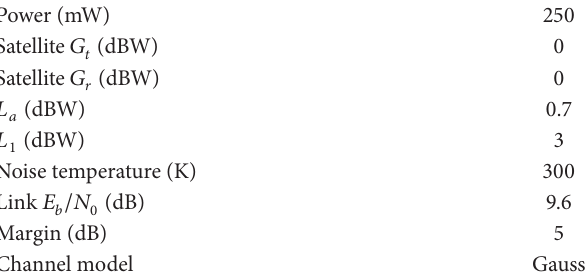
Figure 6: The export signals adding with the initial signals. Table 3: The budgets of intersatellite